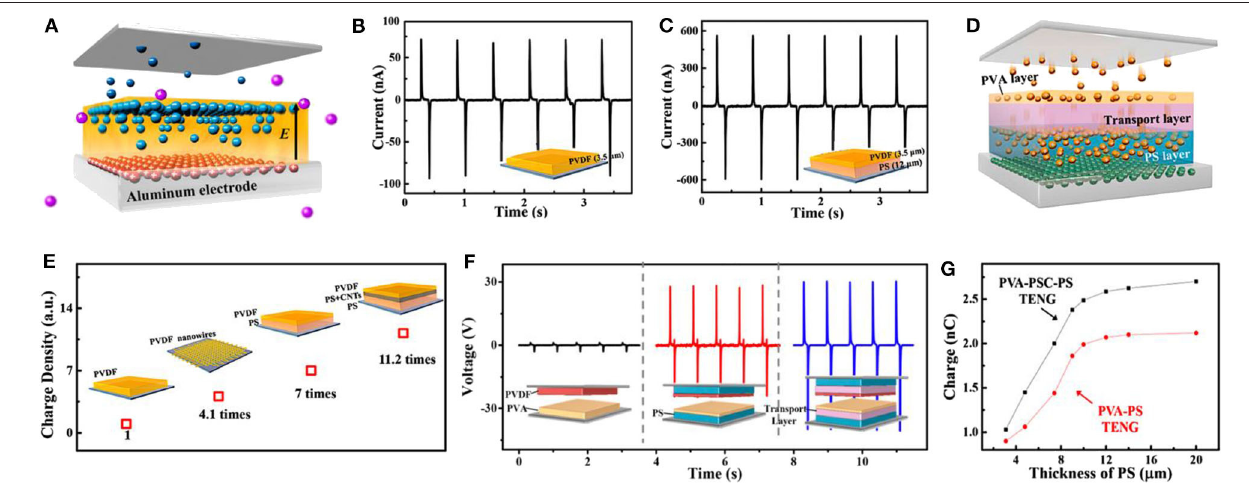
FIGURE 11 | Schematic diagrams and output performance of TENGs with multiple functional sublayers. (A) Schematic diagram of the transport process of triboelectric electrons in the negative triboelectric material of TENG. (B,C) The output comparation of short current generated from TENG (B) without and (C) with PS dielectric sublayer. (D) Improvement effects of different composite friction layer structure. Reprinted with permission from Cui et al. (2016). Copyright 2016 American Chemical Society. (E) Schematic of the electrons transport process of TENG with three-sublayers structure. (F) The voltage of TENG with different sublayers applied in both the positive and negative triboelectric materials. (G) The charge capacity of TENGs fabricated with different thicknesses of PS dielectric layers. Reprinted with permission from Cui et al. (2018). Copyright 2018 American Chemical Society.